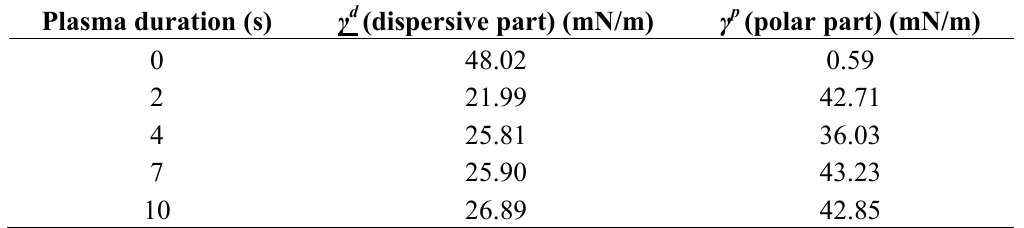
Table 3. The influence of air-plasma treatment for different periods on polar and dispersive components of the surface free energy for PVC films calculated based on various models and reported as an average (Adapted from Kaczemarek et al.